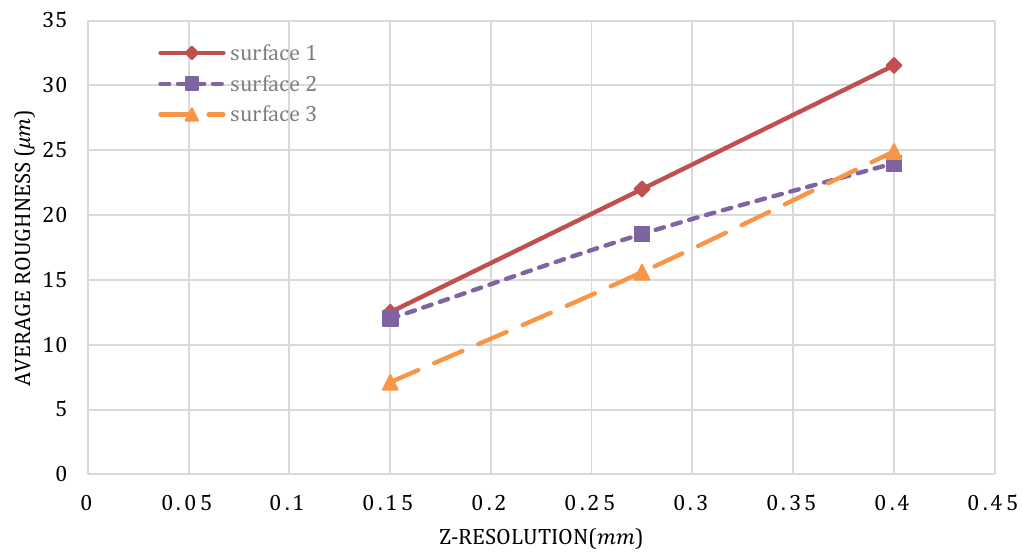
Figure 4: The R a value depending on Z-resolution of two Solid Fill